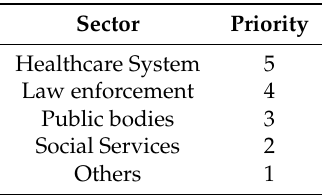
Table 3. Association of priorities to the